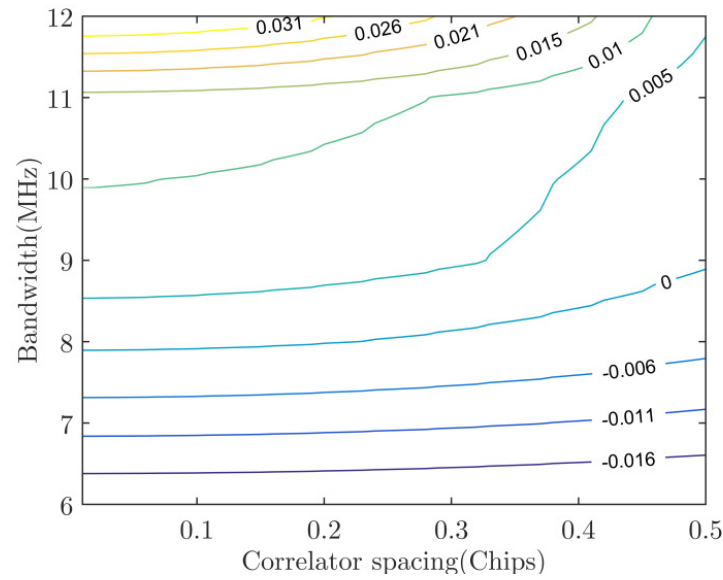
Figure 15. BIII-2 L5-Cd SCB. Table 2. Maximum SCB range.